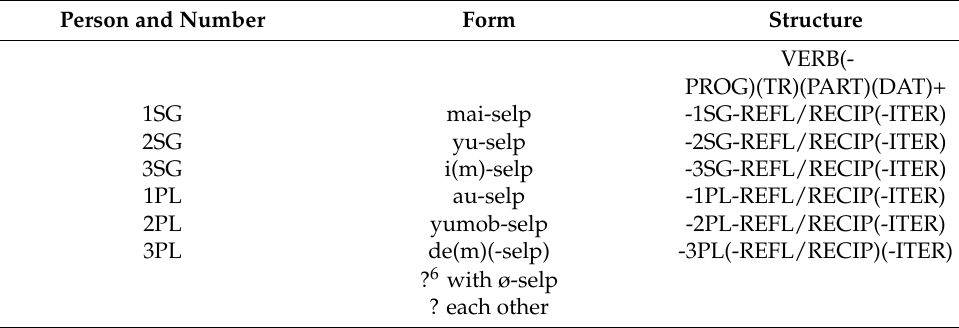
Table 5. Encoding of reflexivity and reciprocity in Light